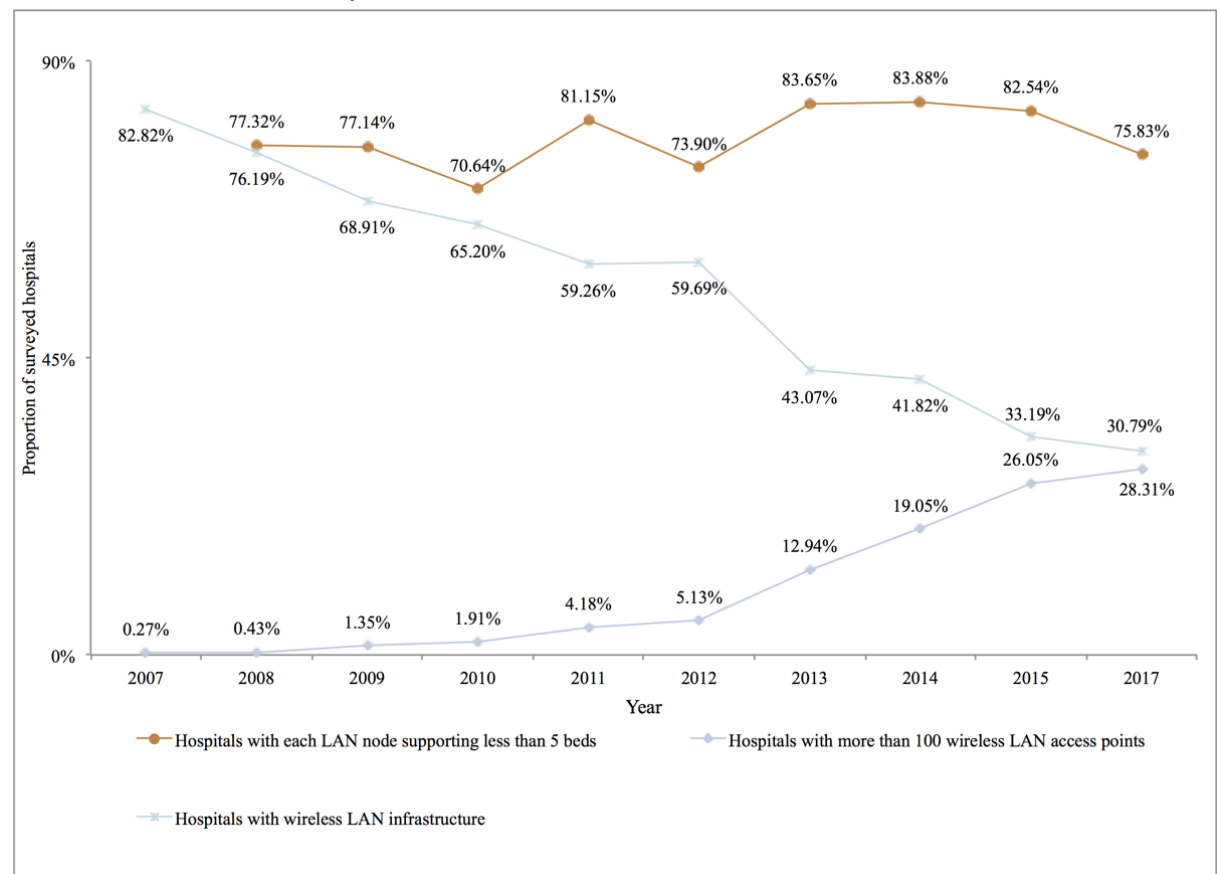
Figure 9. Wired local area network and wireless network facility construction in Chinese hospitals from 2007 to 2017. LAN: local area network. (Note: Wireless network-related indicators were not included in the 2007 CHIMA Annual Survey; relevant indicators on hospital networks were no longer included in the 2018 CHIMA Annual Survey.).